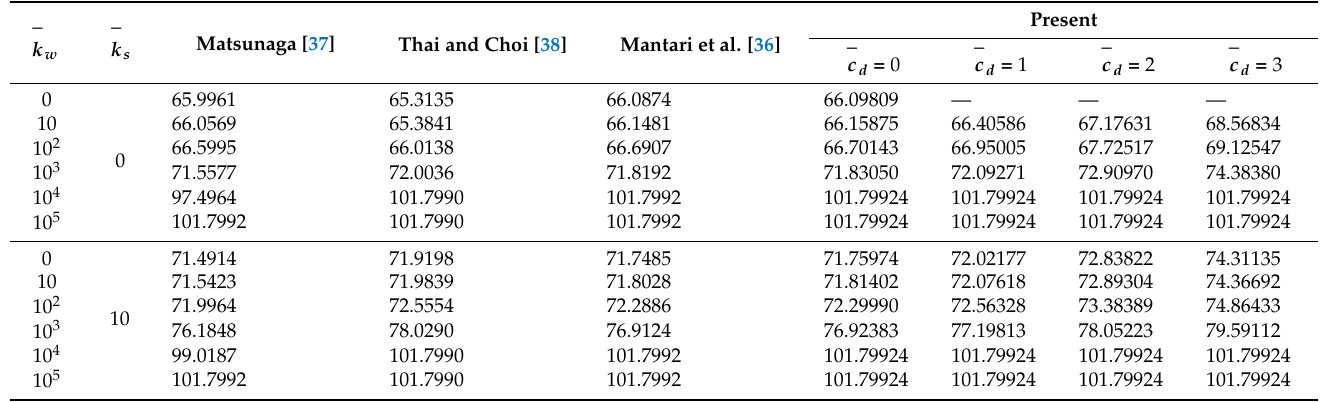
Table 4. Non-dimensional natural frequencies ω = ω a 2 on Visco-Winkler-Pasternak foundations ( a / h = 5, i = 1, j =